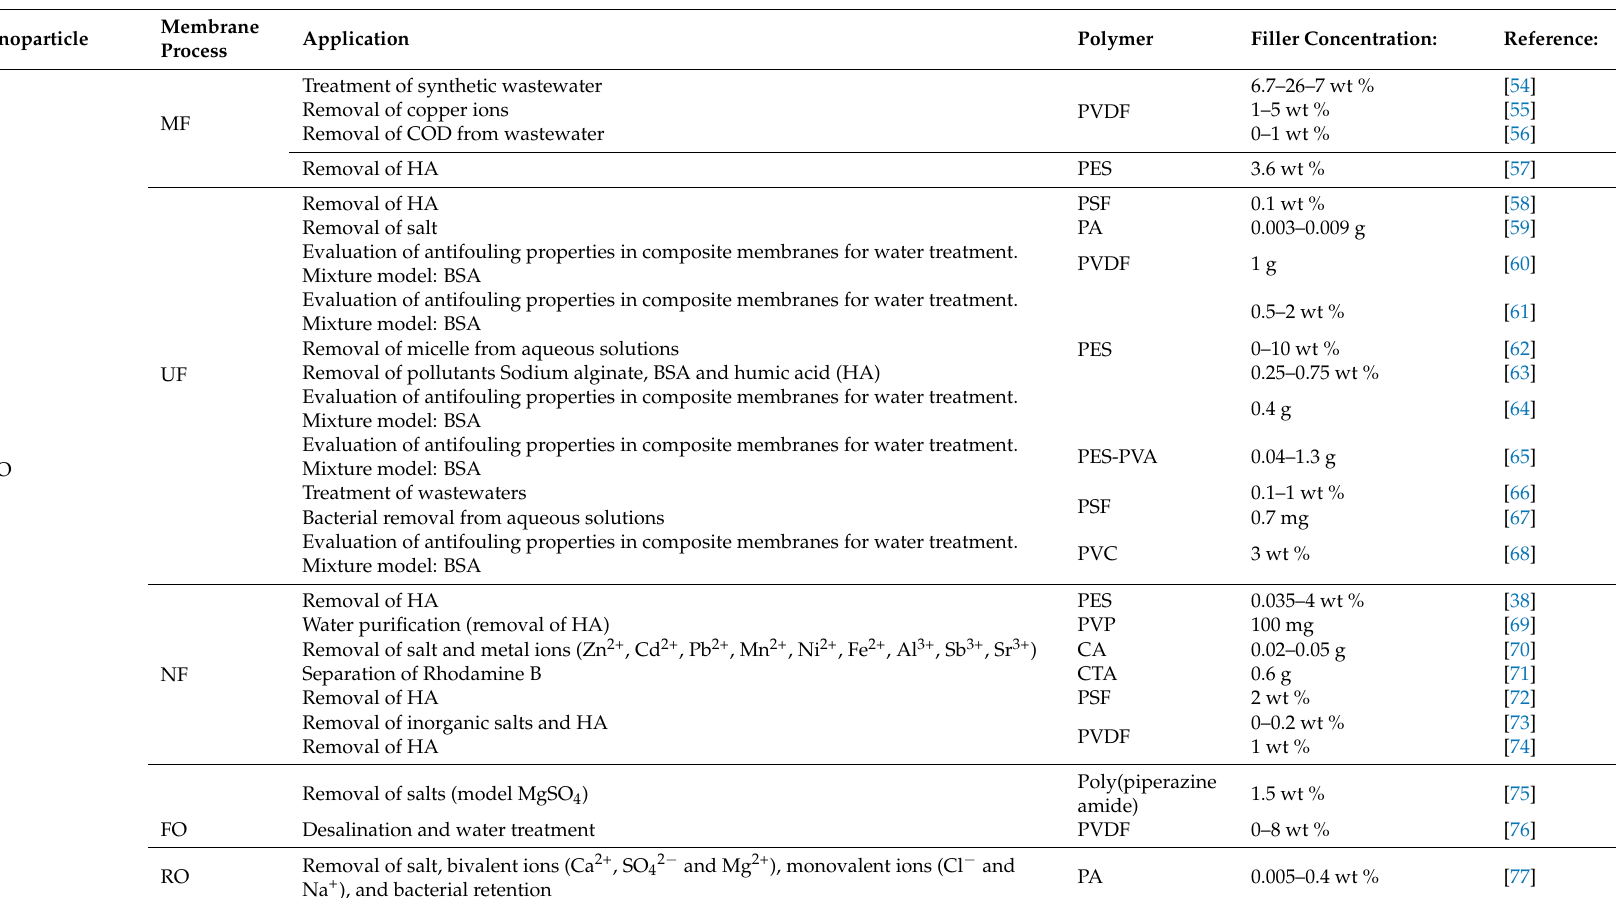
Table 1. Application of different nanoparticles into polymeric membranes for water